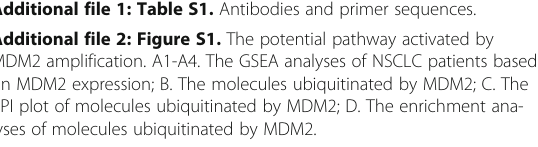
Additional file 2: Figure S1. The potential pathway activated by MDM2 amplification. A1-A4. The GSEA analyses of NSCLC patients based on MDM2 expression; B. The molecules ubiquitinated by MDM2; C. The PPI plot of molecules ubiquitinated by MDM2; D. The enrichment ana- lyses of molecules ubiquitinated by